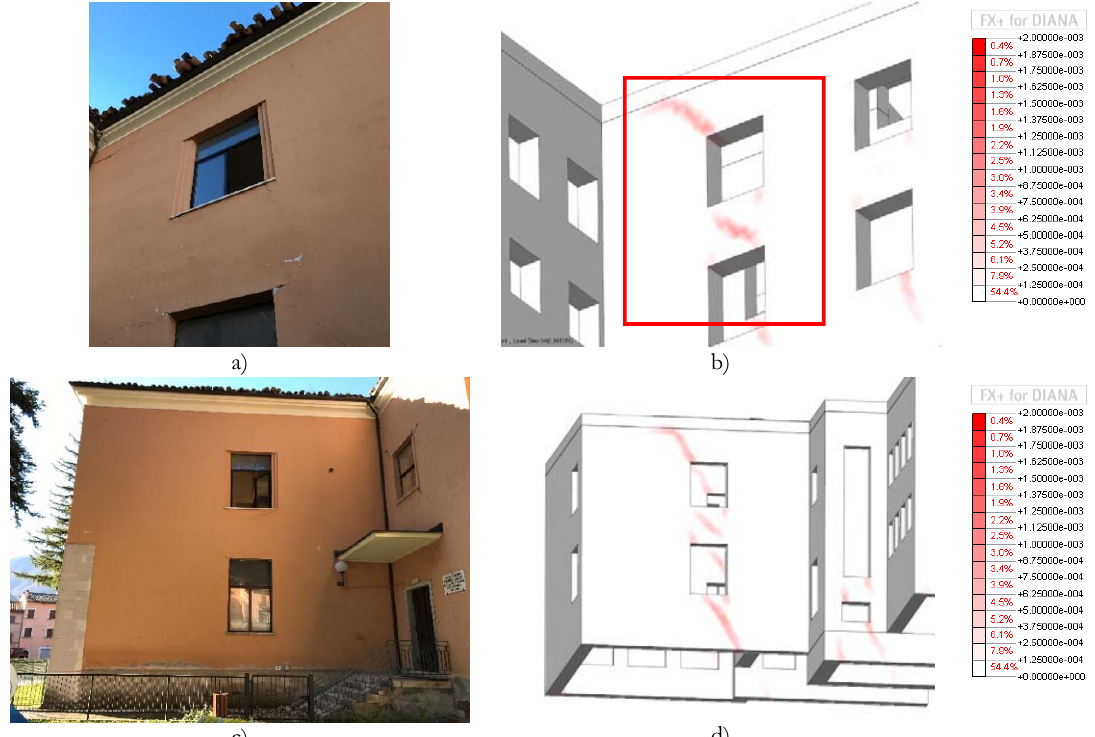
Figure 19: Correlation between the real and numerical damage occurred in the north external walls of body A due to the October 26 th earthquake (PGAx = 0.36 g): a-b) cracks observed in-situ [11, 12], b-d) crack pattern in terms of principal crack width for a horizontal load of 0.37 g in -X